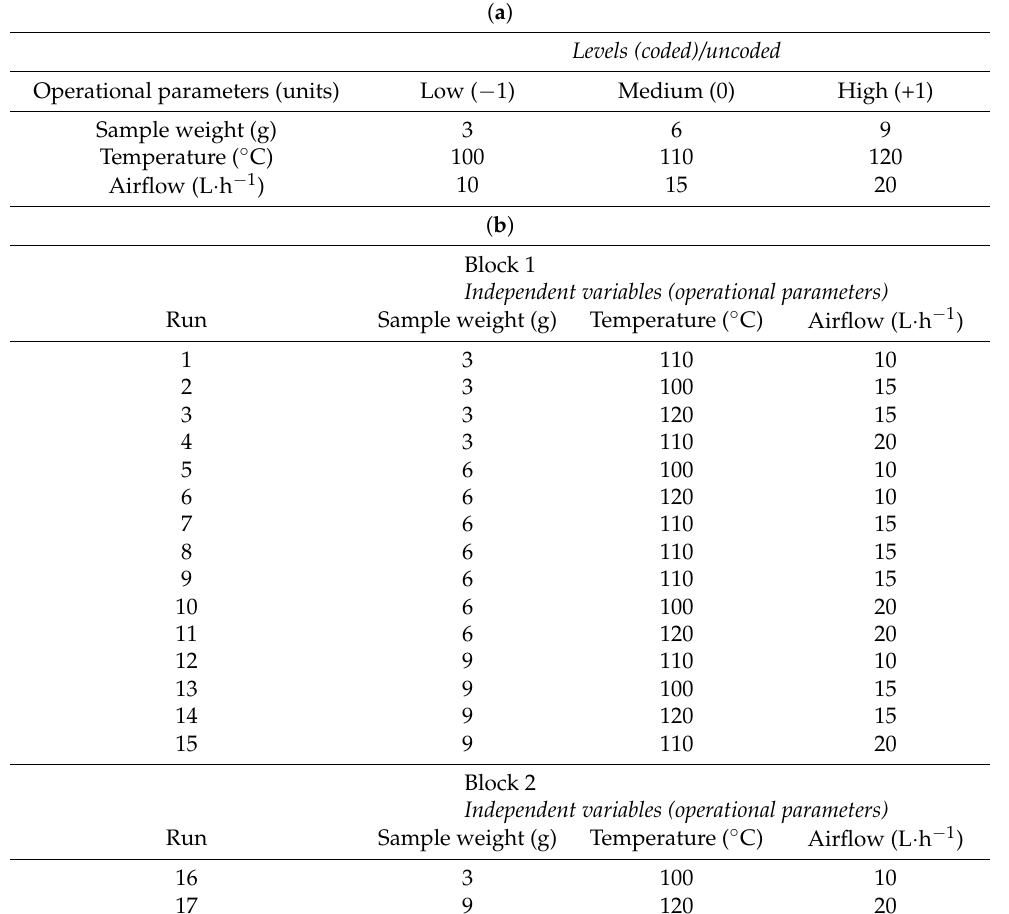
Table 1. ( a ) Box–Behnken statistical design factors. ( b ) Combination of factors in Box–Behnken statistical design. Operational parameters (units) Low ( − 1) Medium